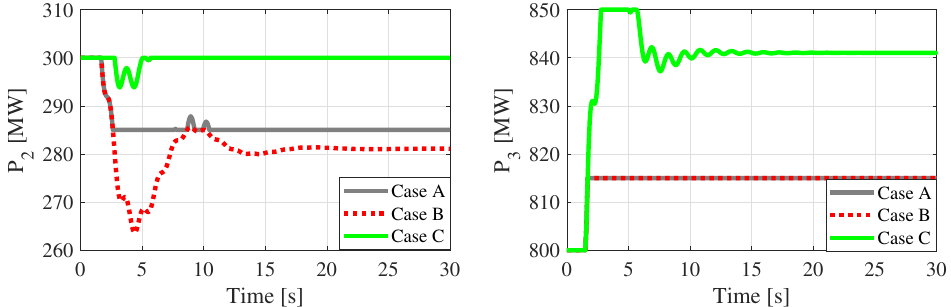
Figure 9. Power fed from VSC2, P 2 , and generated power by the OWF, P 3 , when using CFC from offshore HVDC.